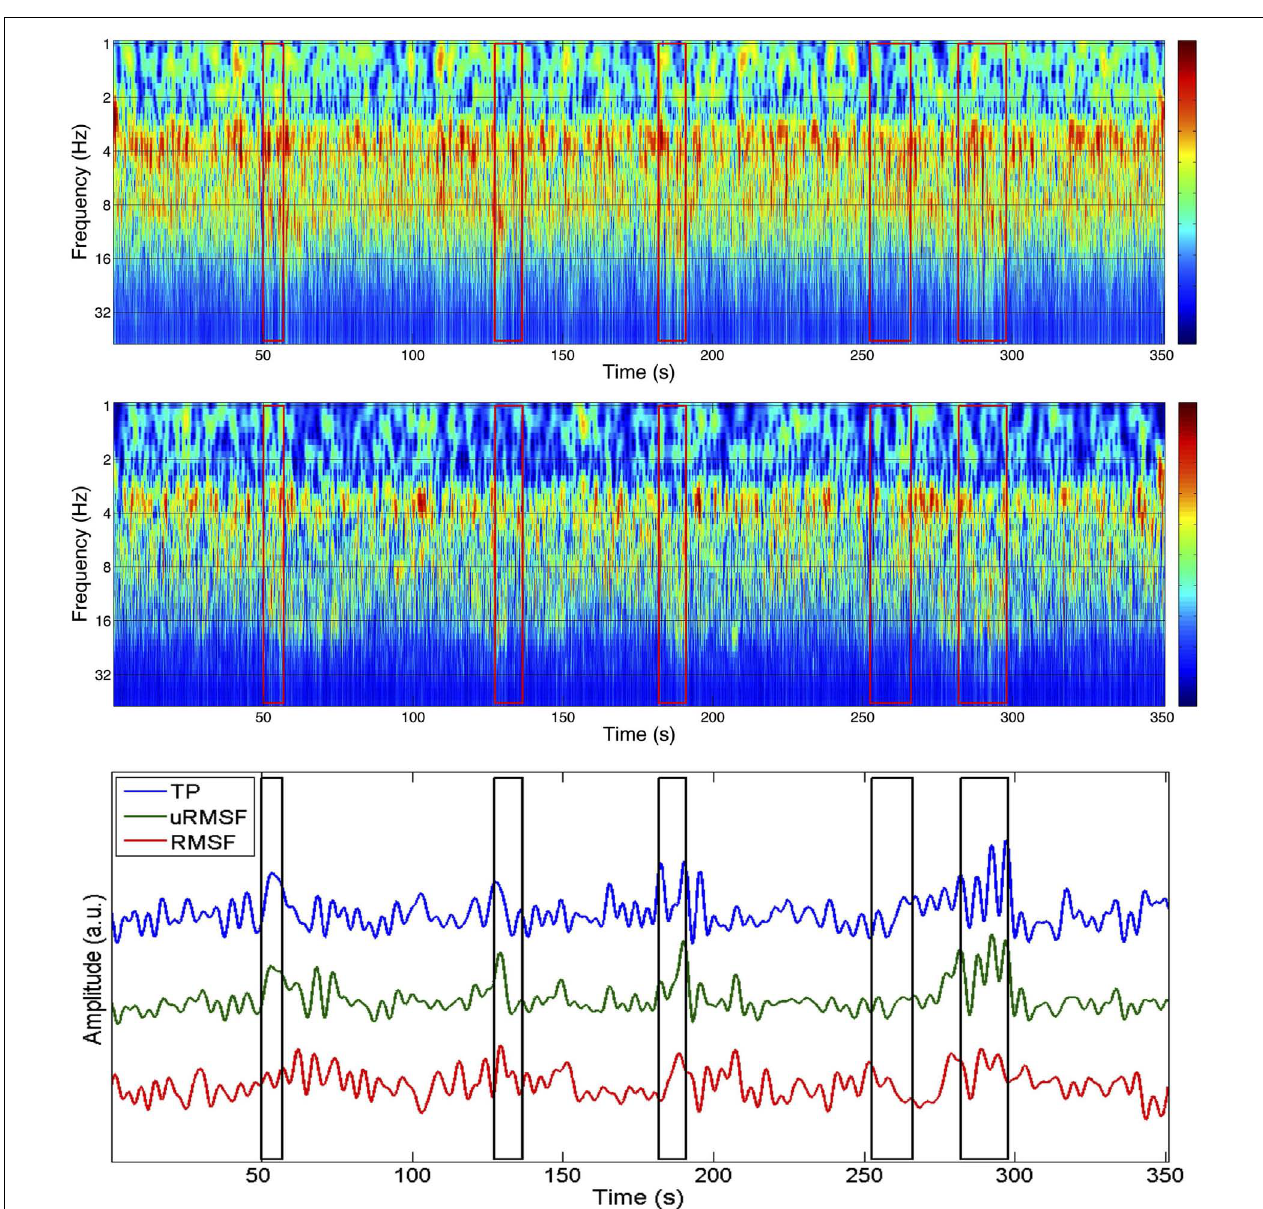
FIGURE 3 | Spectrograms of the time courses of channel P3 (top) and IC 10 (group II; middle) with corresponding EEG metrics (bottom), for the EEG of run 3. The P3 channel was the one that contributed the most to IC 10.The boxes in red/black represent the periods identified as ictal events.